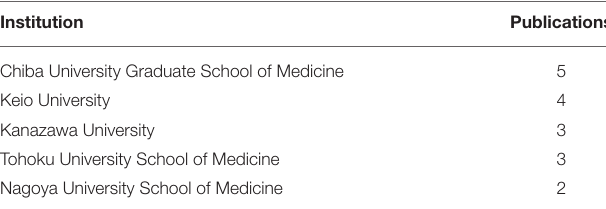
TABLE 5 | Institutions with multiple publications of the 50 top cited articles on